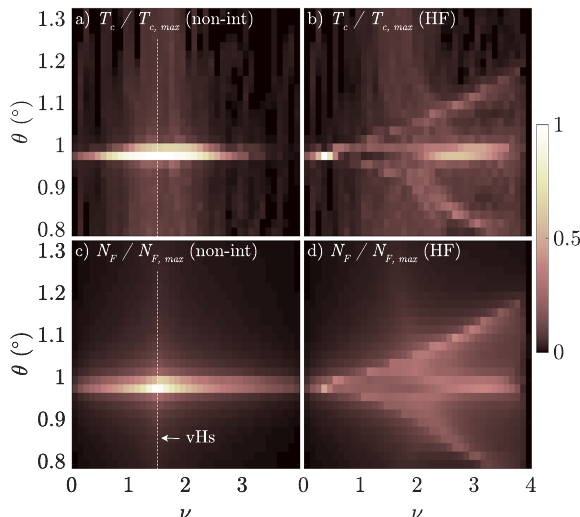
Fig. 2 Pairing temperature with and without HF interactions. T c is obtained from the linearized Eliashberg equation (Eq. 12) as a function of ν and θ for a noninteracting and b HF-corrected bandstructure. The values of T c are normalized in both ( a ) and ( b ) relative to the highest pairing temperature T C ,max in ( a ). The density of states at the Fermi level, N F , as a function of ν and θ for c noninteracting and d HF-corrected bandstructure. In ( a ) and ( c ), the vHs (labeled by white dashed line) is fi xed by parameters of the noninteracting bandstructure and is peaked near the magic angle. With band fl attening, the location of vHs in ( d ) becomes fi lling and twist-angle dependent. (See also Supplementary Discussion and Supplementary Figs. 1, 2 for further comparison of the noninteract- ing and HF-corrected